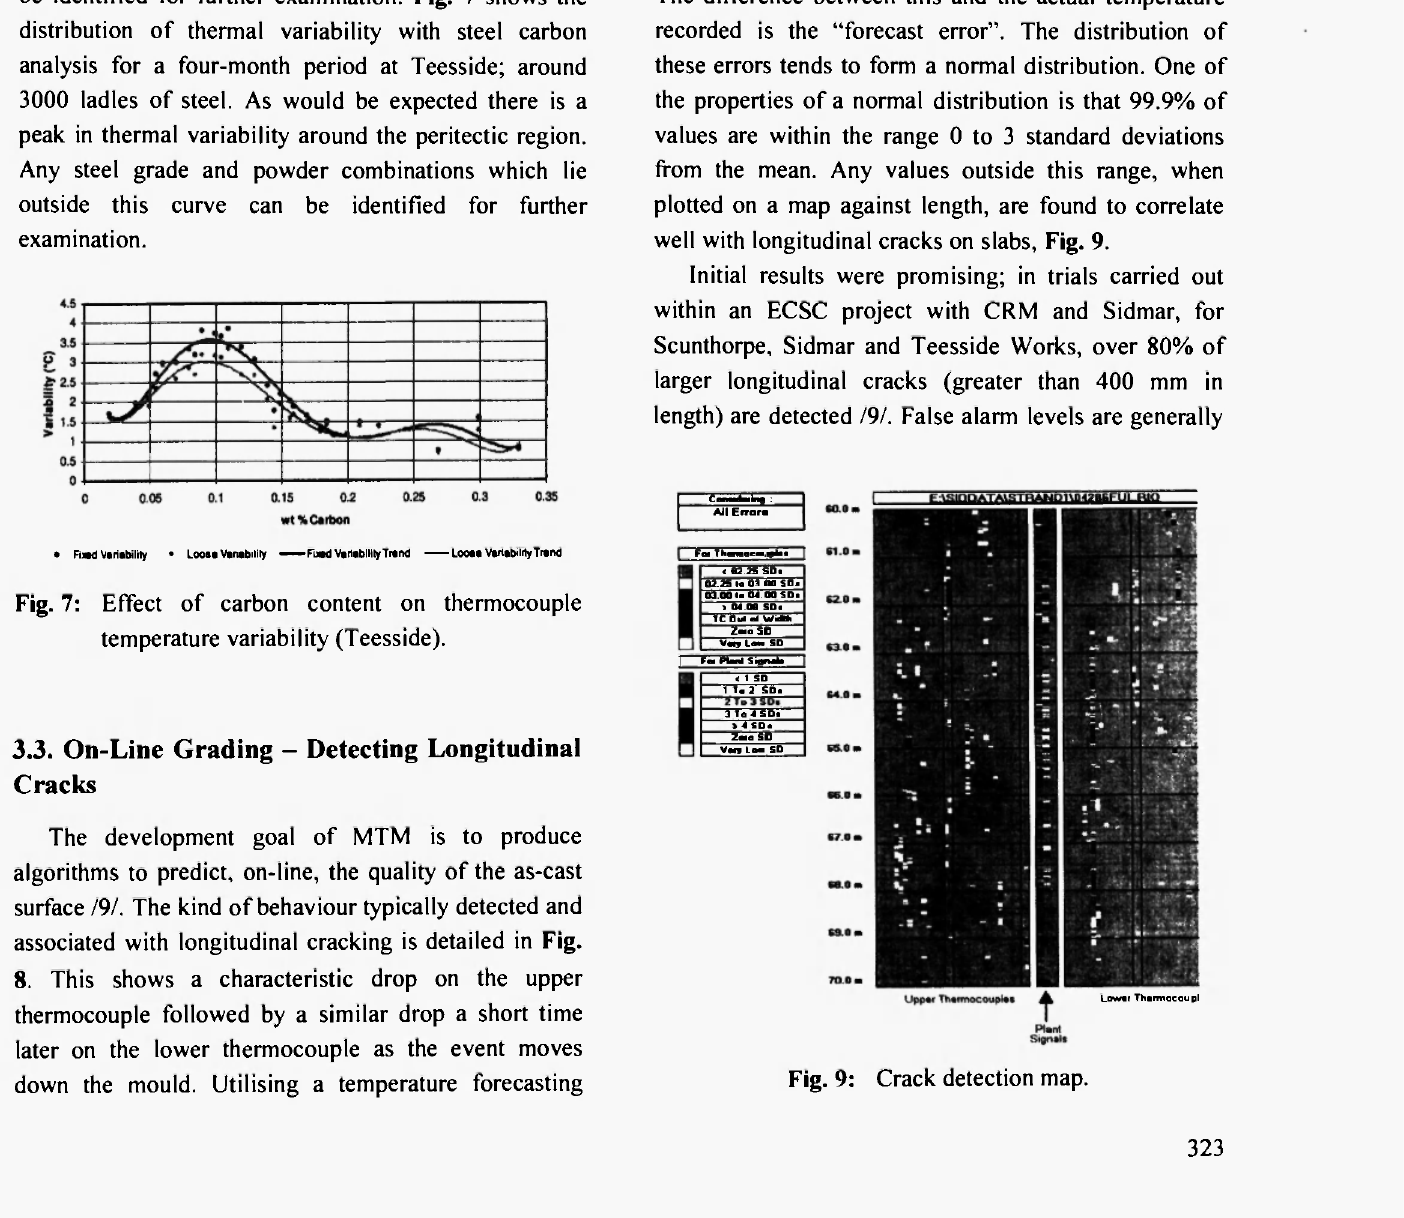
Elapsed Time (minutes) Fig. 8: Thermocouple responses associated with longitudinal cracking events.